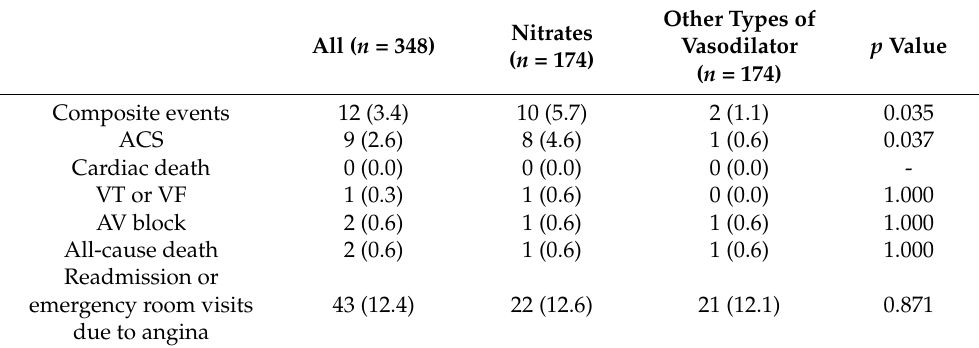
Table 3. One-year clinical event rate of patients with VA according to types of vasodilators after 1:1 propensity-matching.